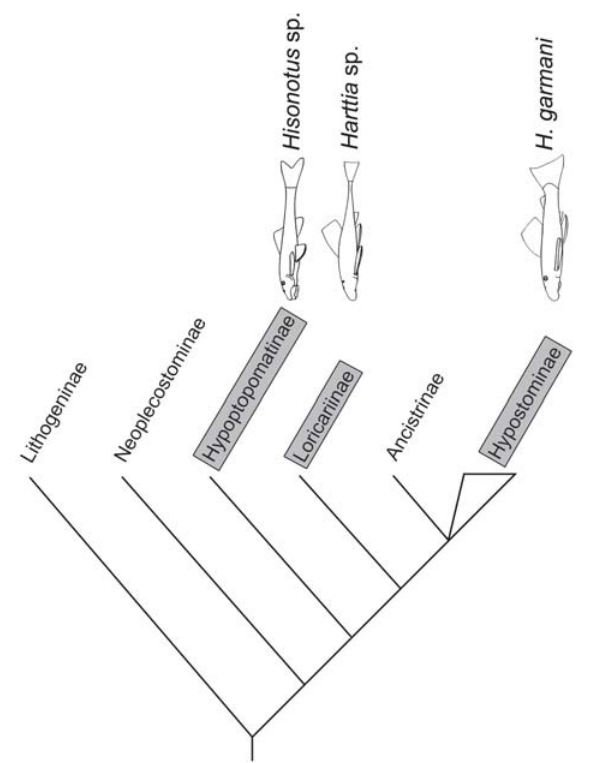
Fig. 8. Cladogram of traditionally accepted phylogenetic re- lationships among Loricariidae subfamilies (modified from de Pinna, 1988: 304), showing the phylogenetic position of the studied loricariid species, an example of ecomorphological adaptive divergence in the studied riffles. According to Armbruster (2004), Ancistrinae is currently considered a dis- tinct tribe within